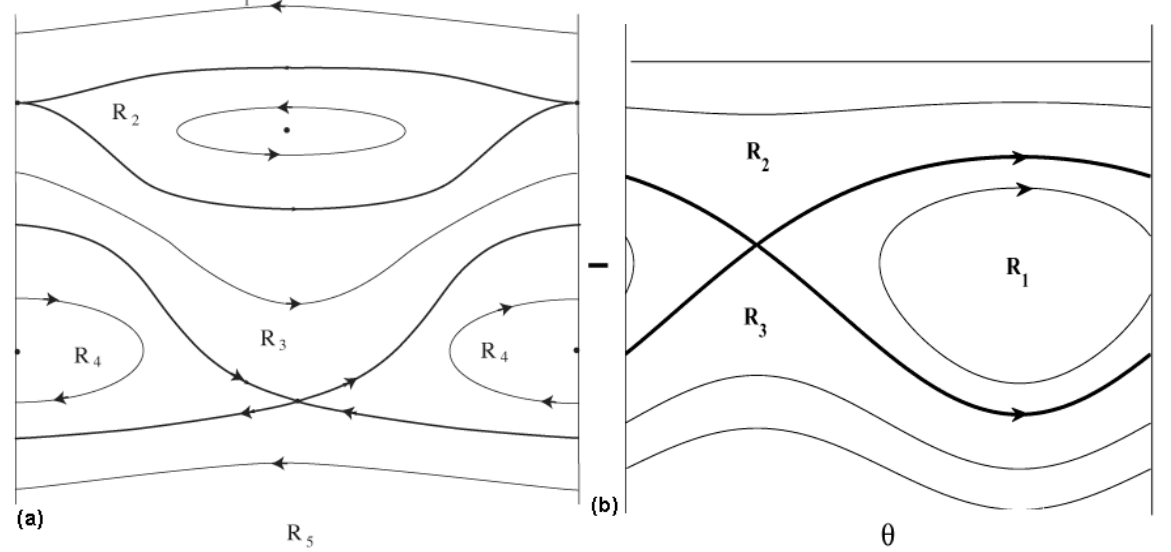
Fig. 2. (a) Streamlines associated with a “jet” (figure from Samelson and Wiggins, 2006) shown in the physical coordinates of the flow; (b) streamlines associated with the “jet” example from Sect. 4 shown in the action-angle variables. The streamlines are shown for b(t) = 0 and ε = 0 .